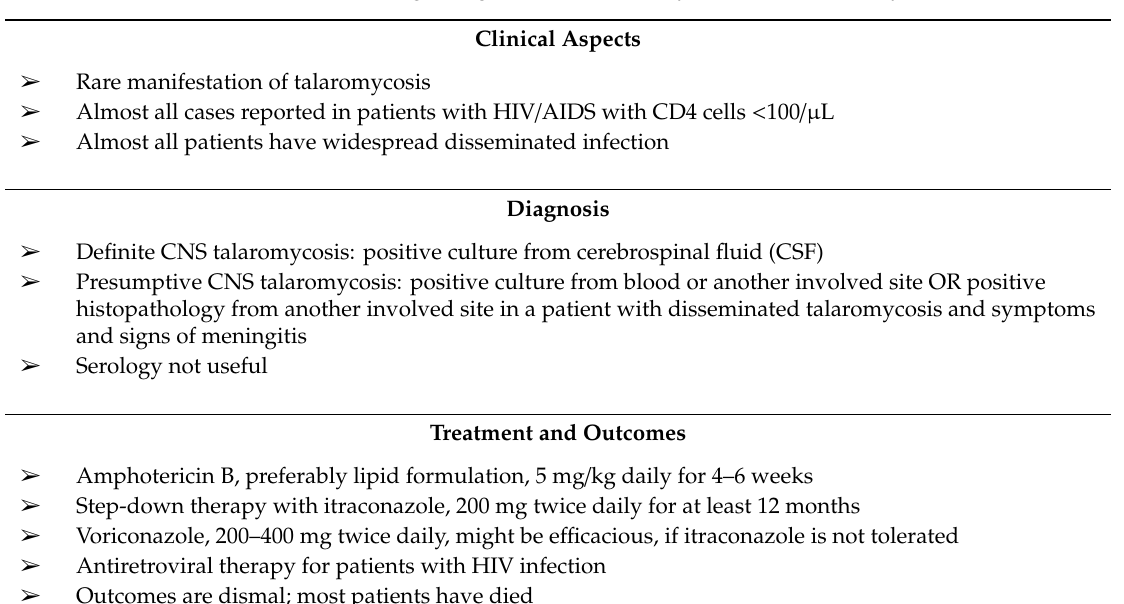
Table 3. Salient Points Regarding Central Nervous System (CNS)